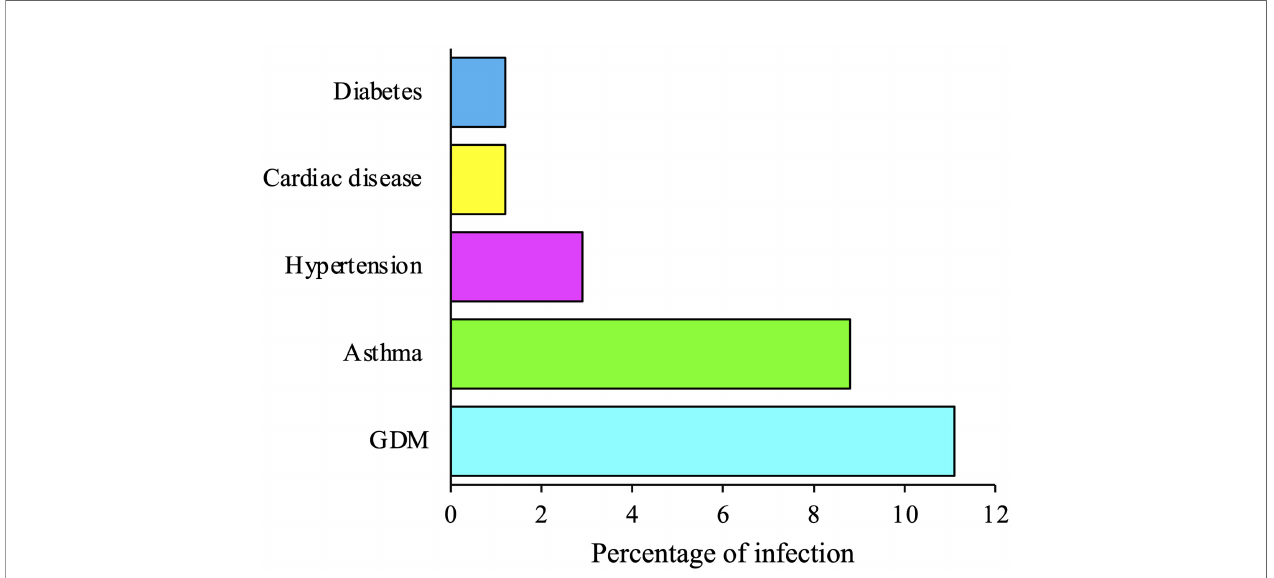
FIGURE 1 | COVID-19 infection of pregnant women with gestational diabetes mellitus (GDM) and comorbidities during Delta period. Schematic representation of GDM infections during COVID-19 Delta variant-of-concern (VOC) period along with comorbidities like diabetes, cardiovascular disease, hypertension, and